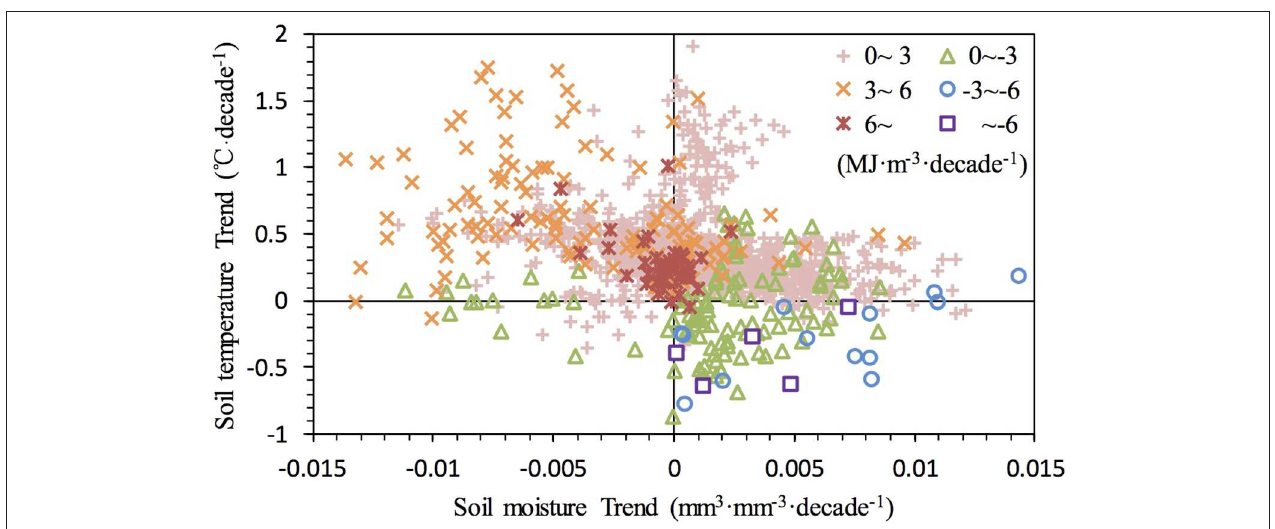
FIGURE 2 | Trends of soil enthalpy vs. those of soil moisture and soil temperature, but for individual trends of soil enthalpy that are significant with p < 0.05.